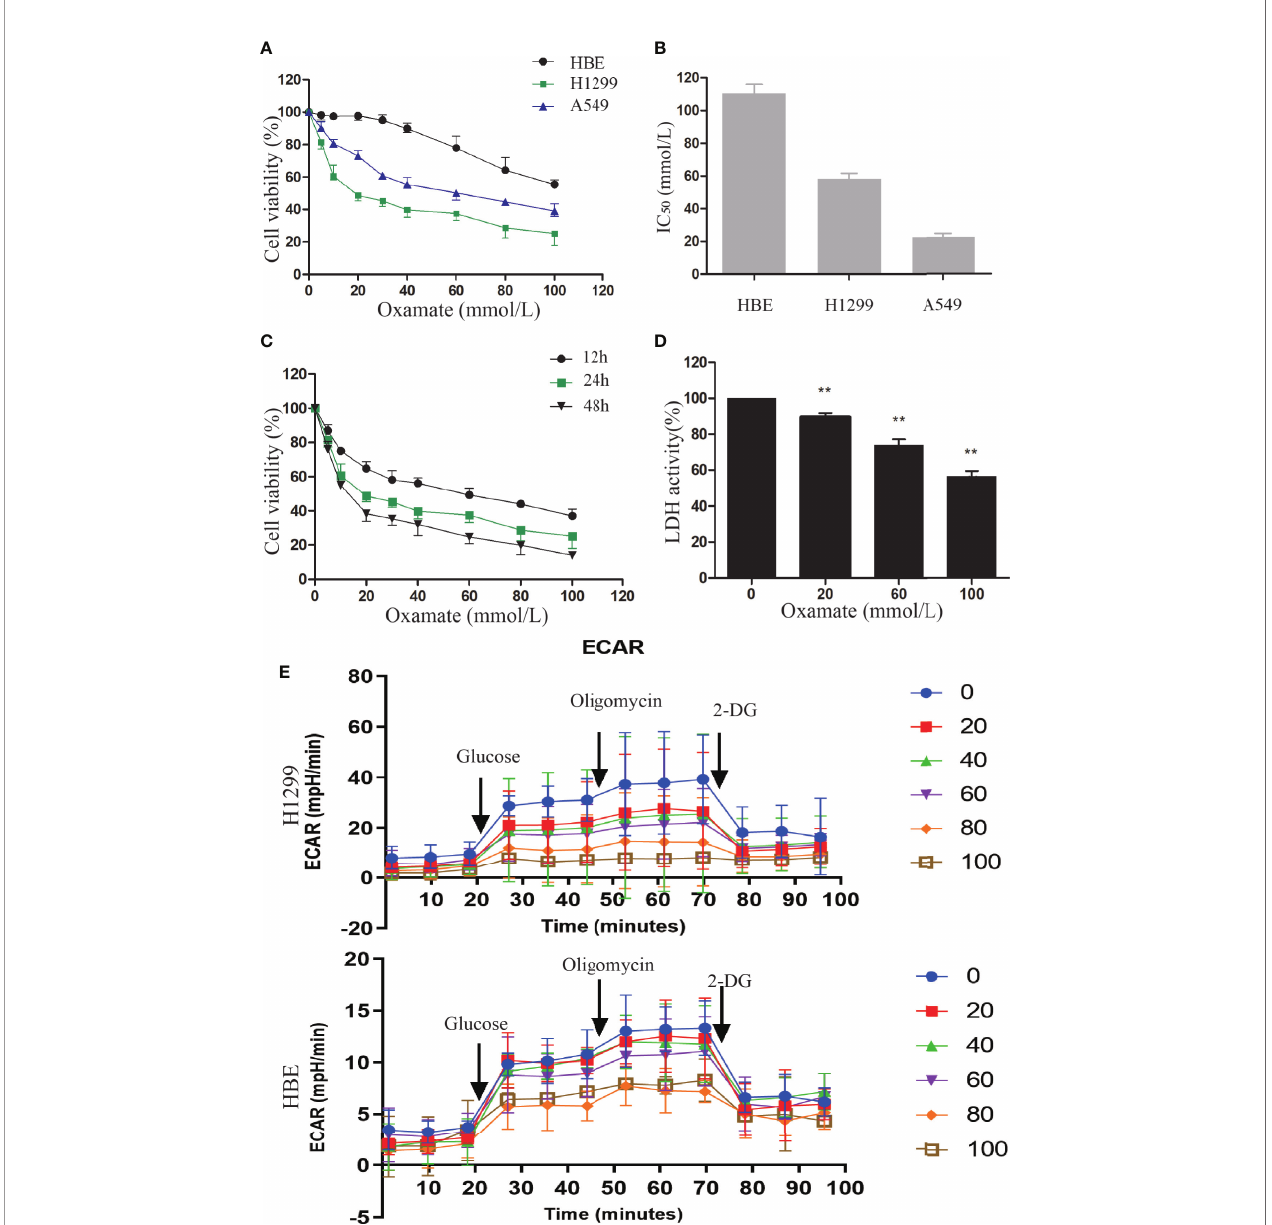
FIGURE 1 | Different effects of oxamate on the cell viability and LDH enzyme activity in NSCLC cells and normal lung epithelial cells. (A) A549, H1299 and HBE cells were exposed to varying doses of oxamate for 24 h, and tested by CCK-8 assay. Cell viability was calculated as a percentage of untreated cells (100%); values are represented as means ± SD; n=4. (B) IC 50 of different cells at 24h were calculated by the growth curves. (C) The effect of oxamate on H1299 cells was determined at different time points. (D) Cells were treated with 0, 20, 60 and 100 mM oxamate for 24 h and using a commercially available kit to determine the intracellular LDH enzyme activity. Values are represented as means ± SD; n=6. **P<0.01 vs. the untreated control. (E) Cells were treated with 0, 20, 40, 60, 80 and 100 mM oxamate for 24 h and using a glycolysis stress test to determine the glycolysis ability. 2-DG, 2-deoxy-d-glucose; oligo, oligomycin; Values are represented as means ± SD;